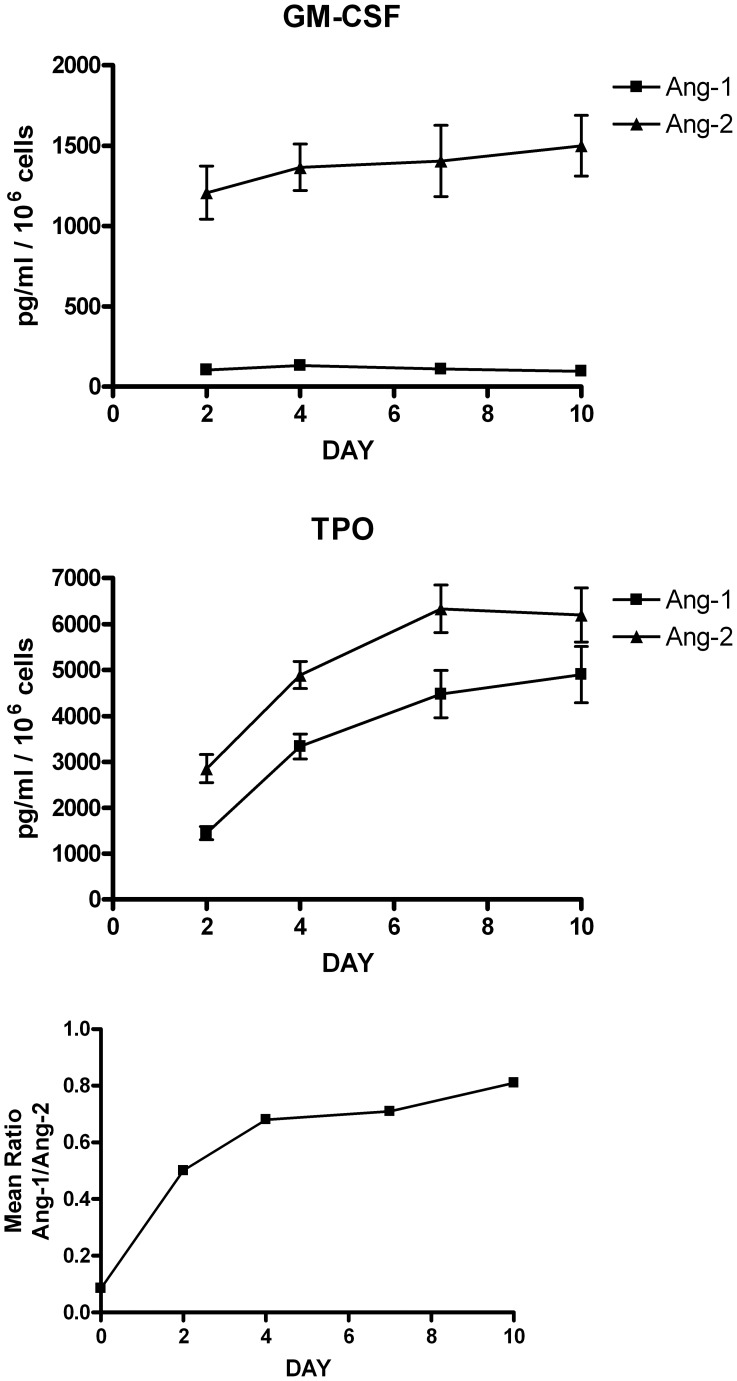
Release of angiopoietins during differentiation of UT7/mpl cells.UT7/mpl cells have been grown for 7 days in the presence of either GM-CSF (Top Panels) or TPO (Middle Panels) and the concentration of Ang-1 and Ang-2 in the culture supernatants was evaluated by a sensitive and specific ELISA assay. The levels of angiopoietins reported in the figure correspond to the accumulated amount of angiopoietins during the culture. Mean values ± SEM observed in three separate experiments. In the bottom panel the ratio Ang-1/Ang-2 at various days of culture is plotted.